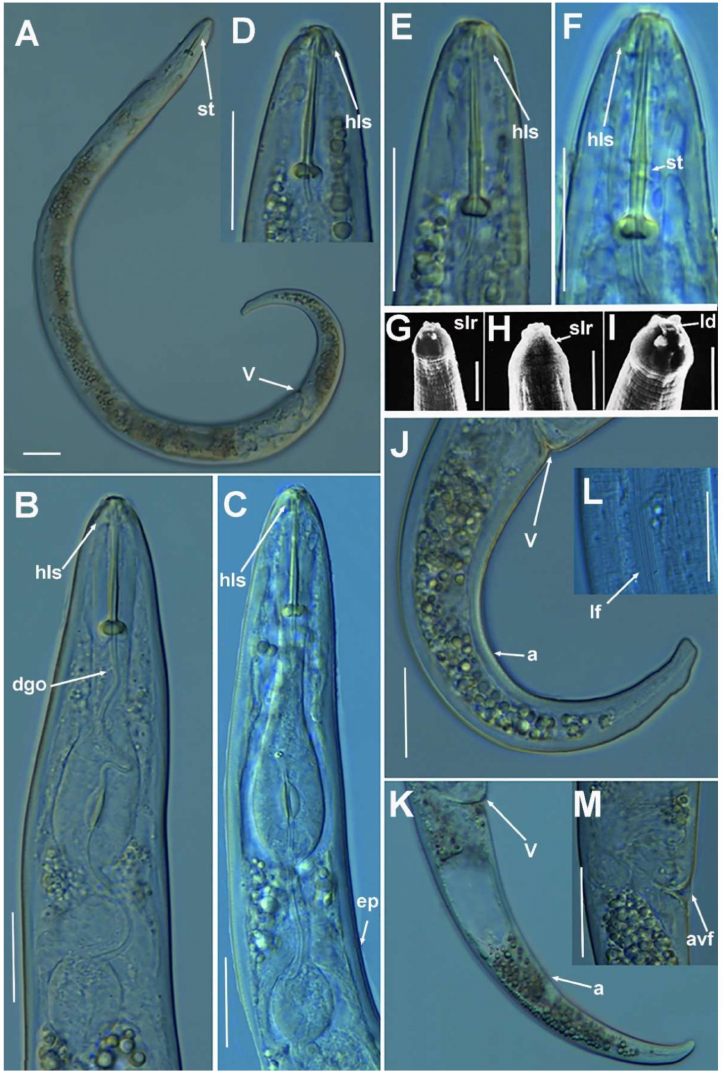
Figure 10. Light and SEM photomicrographs of Paratylenchus sheri (Raski, 1973) Siddiqi, 1986. ( A ) En- tire female with stylet and vulva arrowed; ( B , C ) female pharyngeal region showing heavy lip sclero- tization (arrowed); ( D – F ) female lip region showing heavy lip sclerotization (arrowed); ( G – I ) detail of lip region at SEM showing smooth lip region and labial disc (arrowed); ( J , K ) female posterior region with vulva and anus (arrowed); ( L ) detail of lateral field at mid body (arrowed); ( M ) detail of vulva showing advulval flap (arrowed). Scale bars ( A – F = 20 µ m; G – I = 5 µ m; J – M = 20 µ m). (Abbreviations: a = anus; avf = advulval flap; dgo = pharyngeal dorsal gland orifice; ep = excretory pore; hls = heavy lip sclerotization; ld = labial disc; slr = smooth lip region; st = stylet; V =